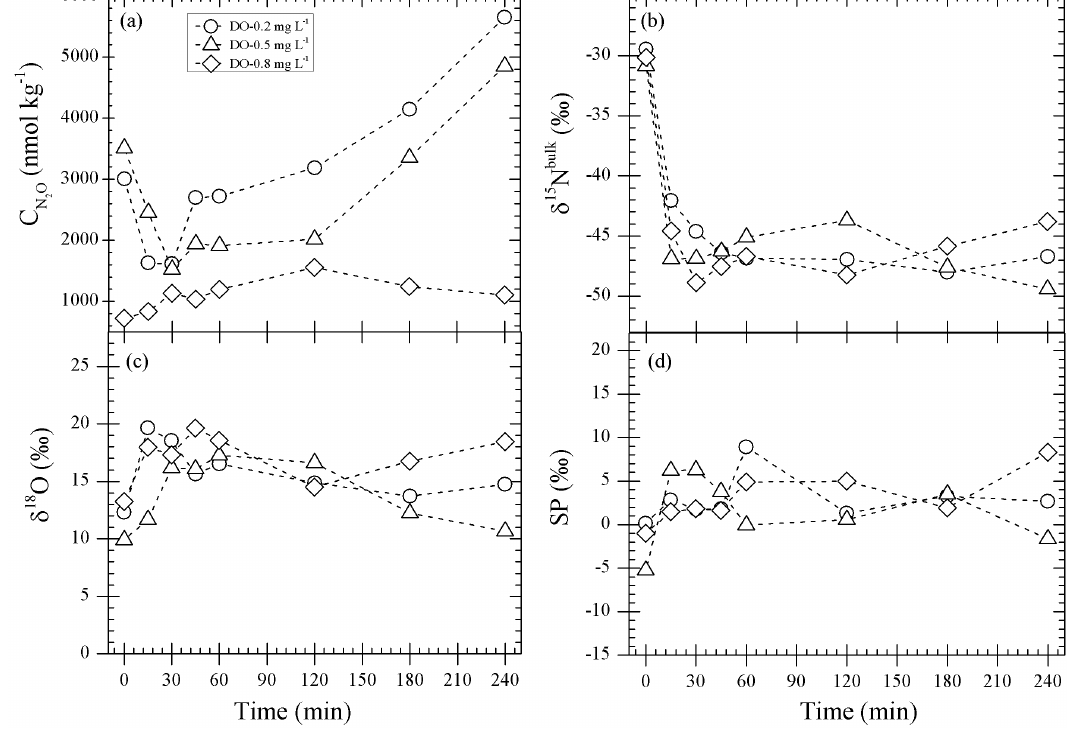
Fig. 2. Time course of concentration of N 2 O ( a ) and its isotopomer ratios (δ 15 N bulk , SP, d 18 O) ( b-d ) under aerobic condition with different DO